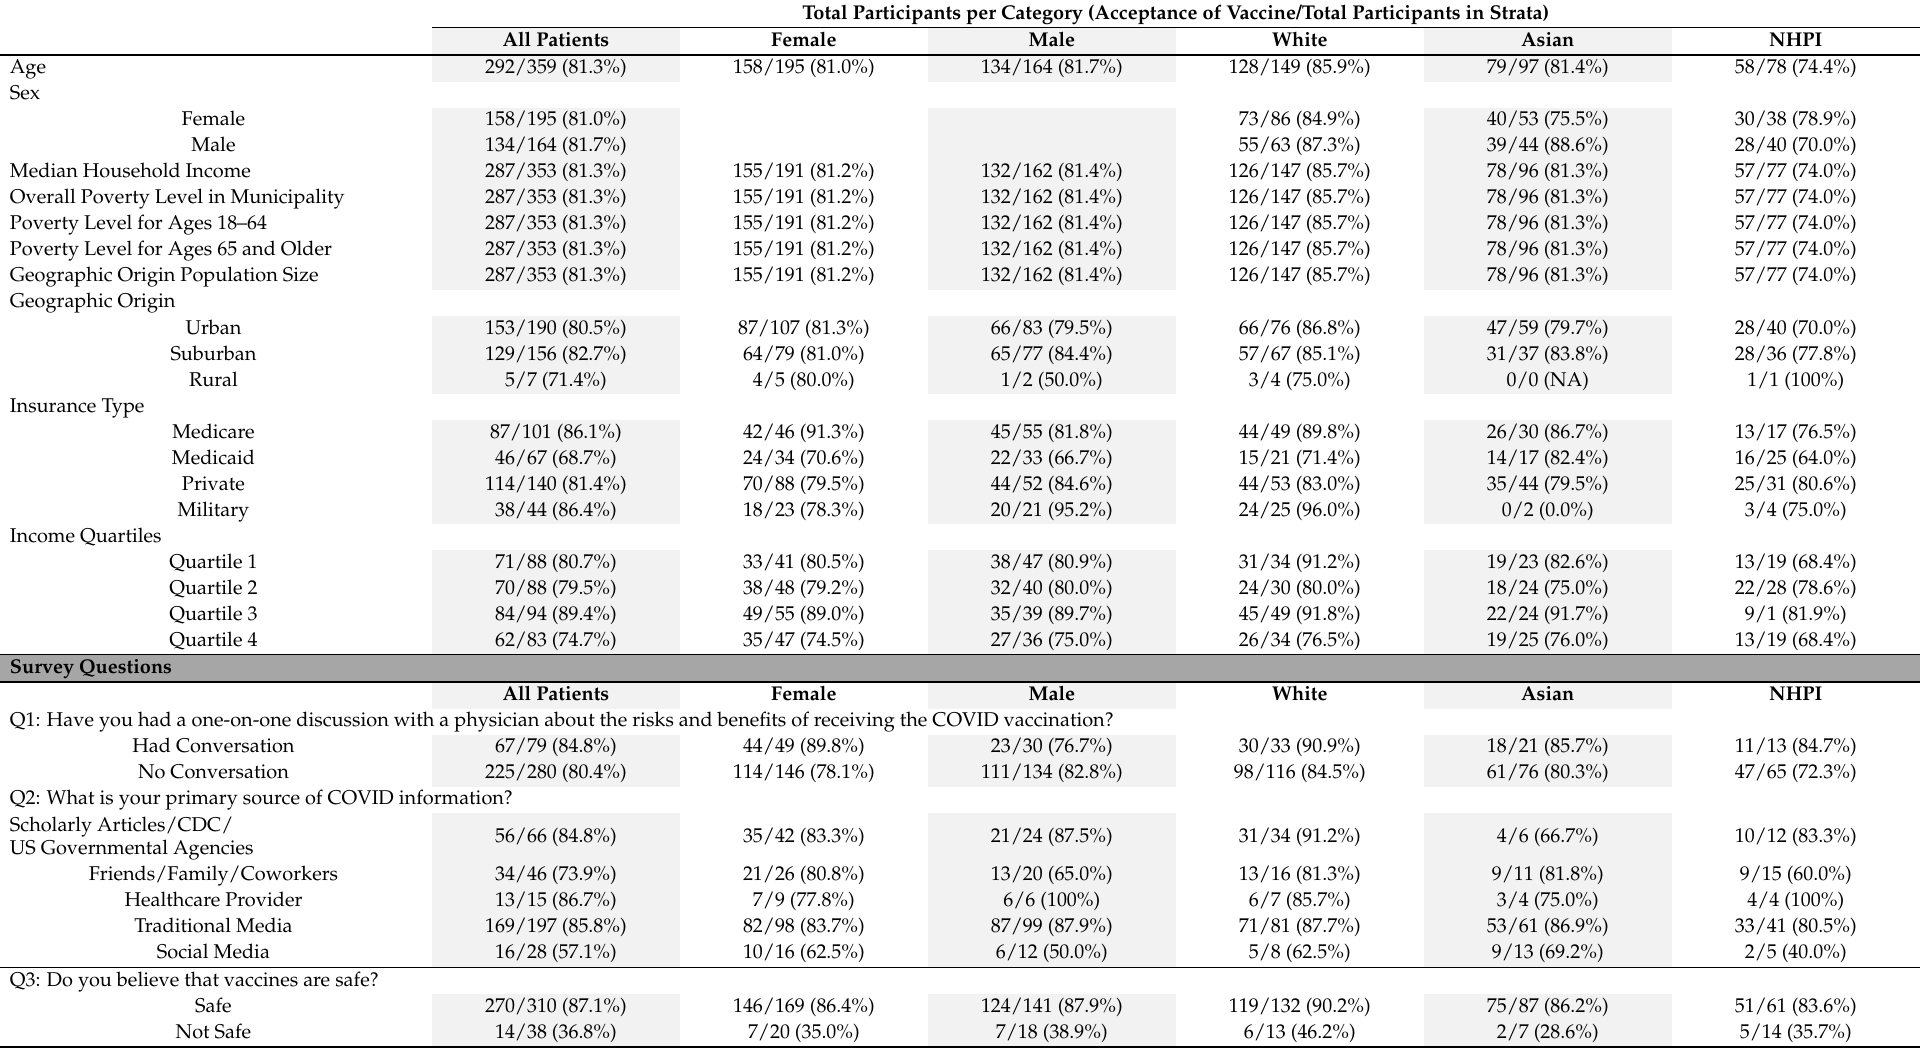
Table 1. Number of patients stratified by sociodemographic variables and